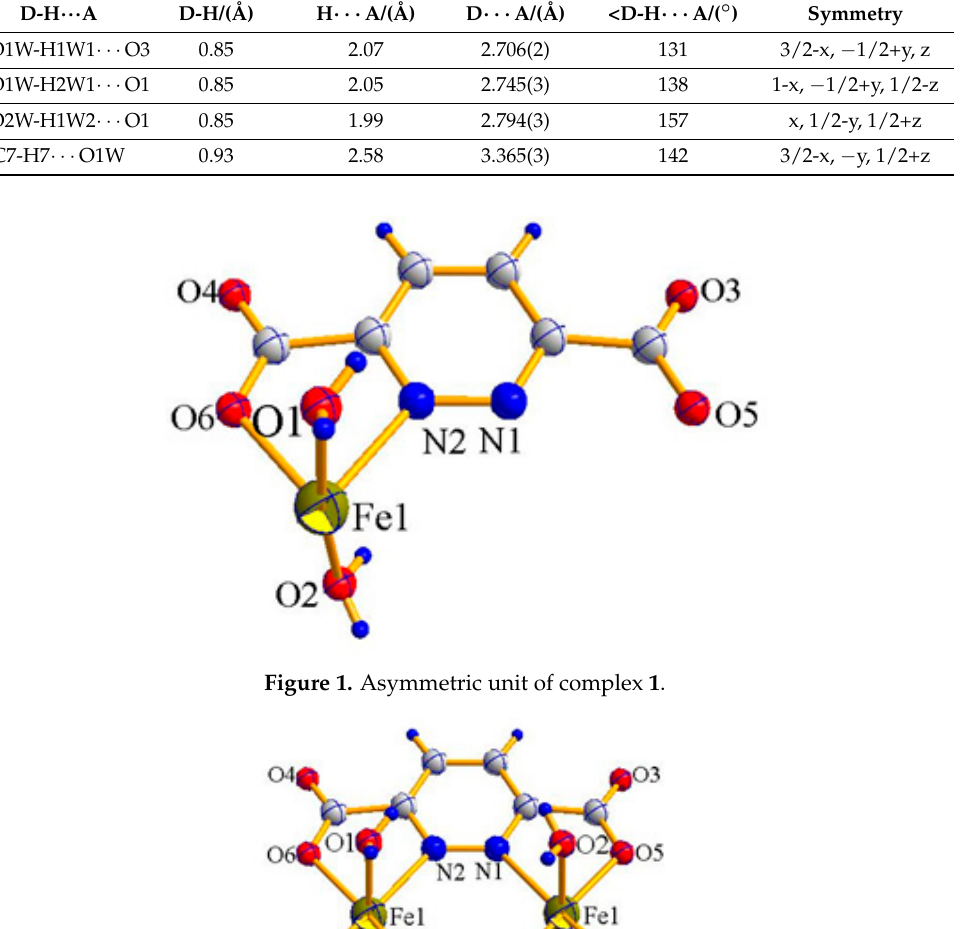
Table 3. Selected hydrogen bond dimensions in complex 1.